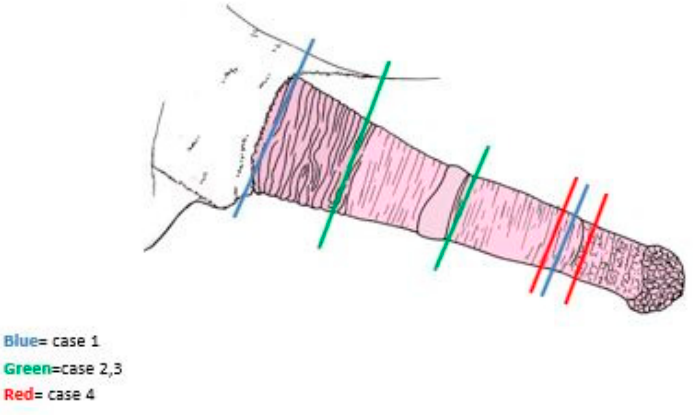
Figure 13. Levels of incisions of segmental posthetomy.